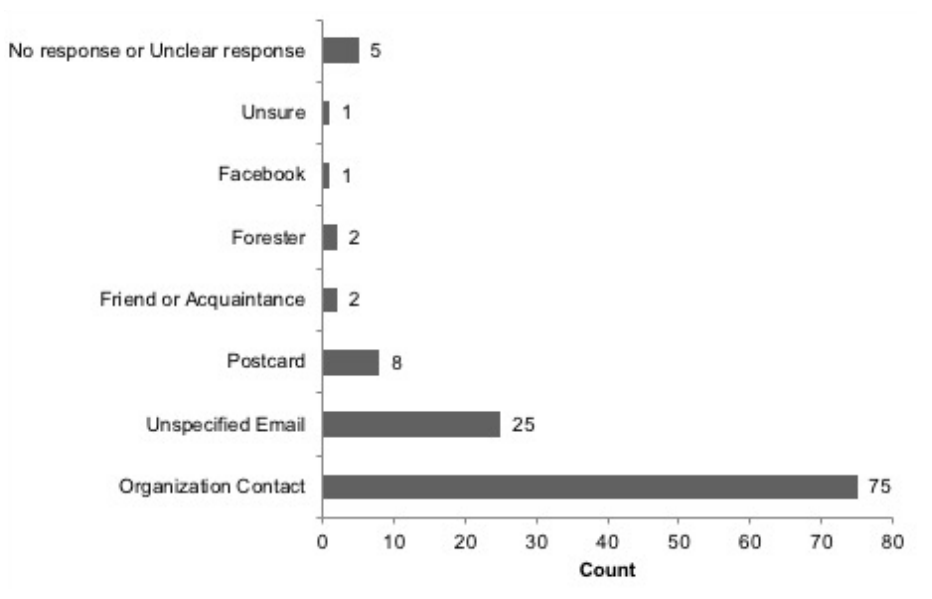
Figure 2. Activities from the past five years from all pre-survey respondents .